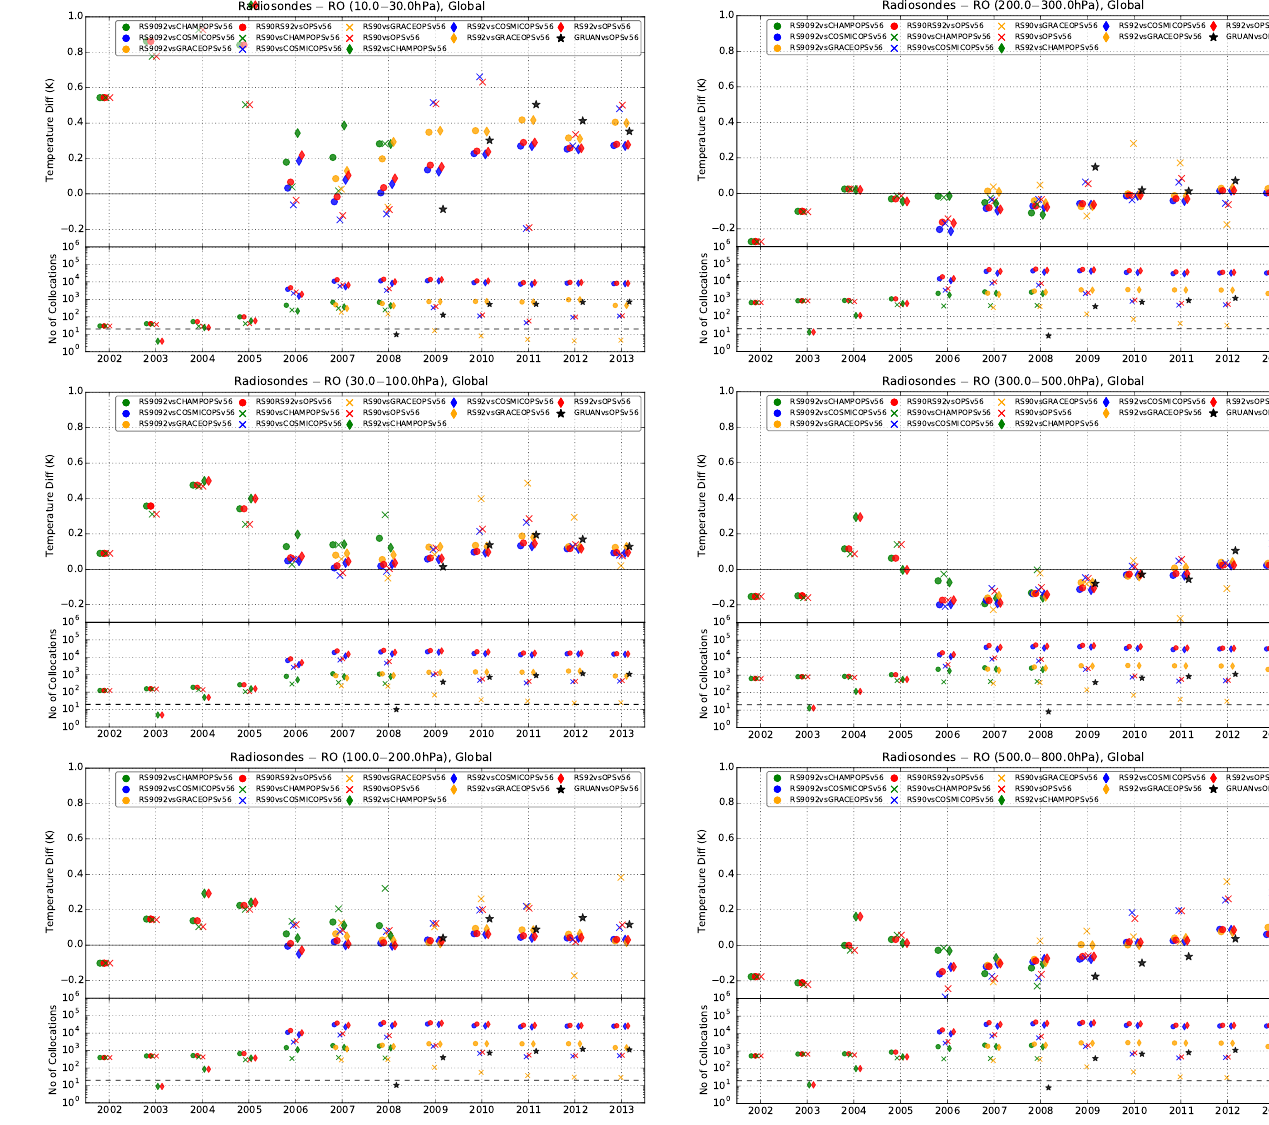
Figure 4. Global annual mean temperature differences over 2002 to 2013 between RS and GPSRO for stratospheric pressure layers 10 to 30hPa (top), 30 to 100hPa (middle), and 100 to 200hPa (bottom). Different RS instrument types and different GPSRO missions (cor- responding to different receivers) are indicated by different symbols and colors as summarized in the in-panel legend. RS90RS92 indi- cates the combined set of RS90 and RS92 instruments. The number of collocations is shown at the bottom of each panel.